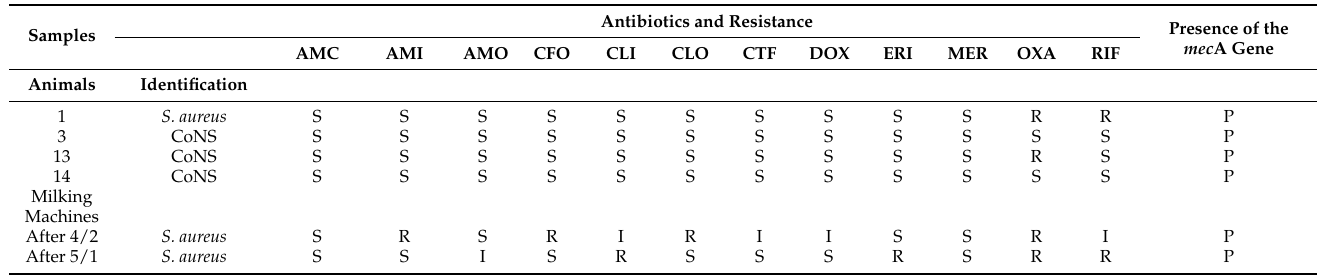
Table 5. Resistance profile of Staphylococcus spp. mec A gene carriers, from the municipality of Boa Esperança, northwestern Paran á State, Brazil, May–June 2022.